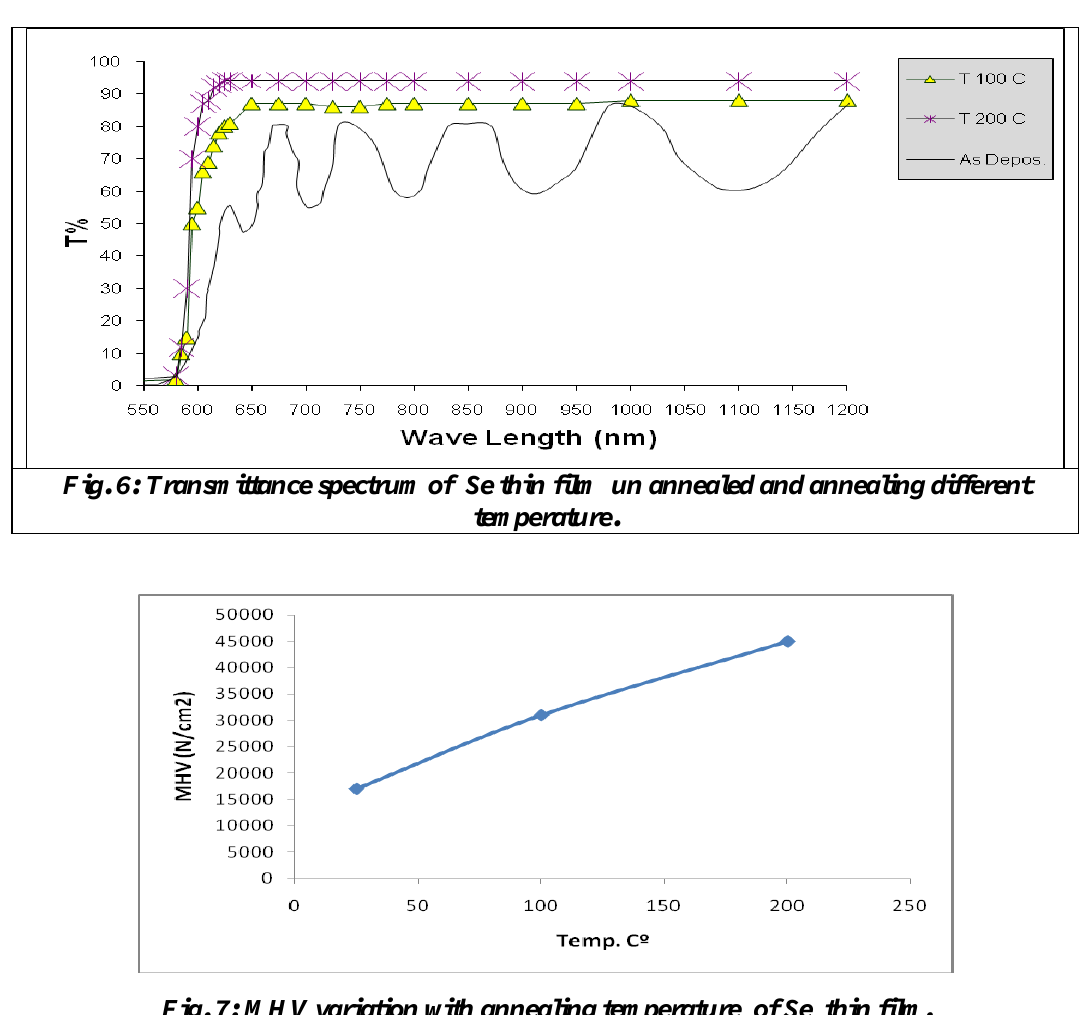
Fig. 7: MHV variation with annealing temperature of Se thin